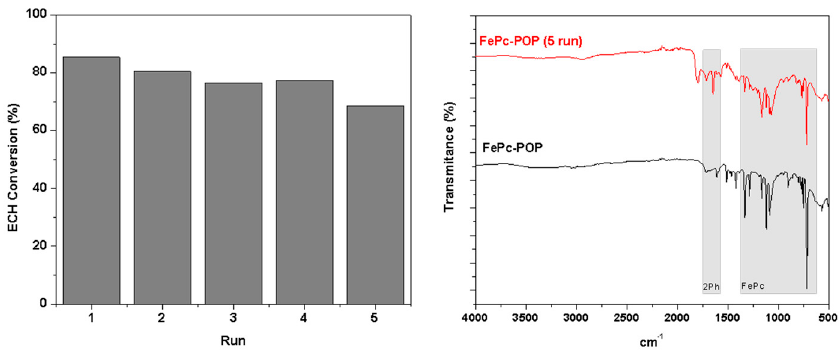
Recycling experiments using FePc-POP as catalyst in the cycloaddition of CO 2 to epichlorohydrin ( left ) and FT-IR spectra of catalyst before and after recycling ( right ).